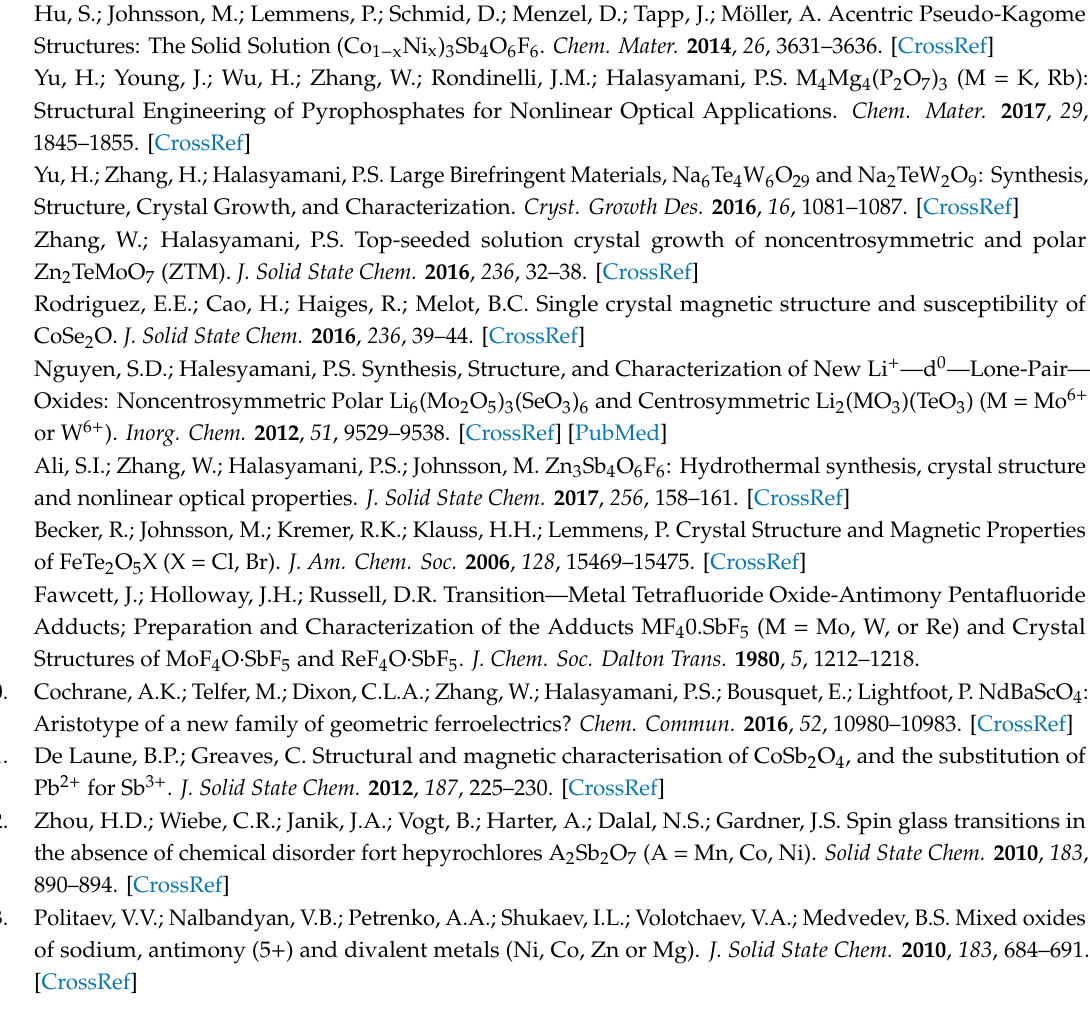
Table S1: Qualitative EDS analyses on single crystals were performed in a scanning electron microscope (JEOL-7000F) showing that all the intended elements are present in Fe 0.43 Mo 2.56 SbO 9.5 . Average composition is calculated considering several points in a crystal. Table S2: (a) Structural parameters of the cations and (b) anions in Fe 0.43 Mo 2.56 SbO 9.5 (Occ. = Occupation factor).Details of crystallographic file is deposited to CCDC (CCDC